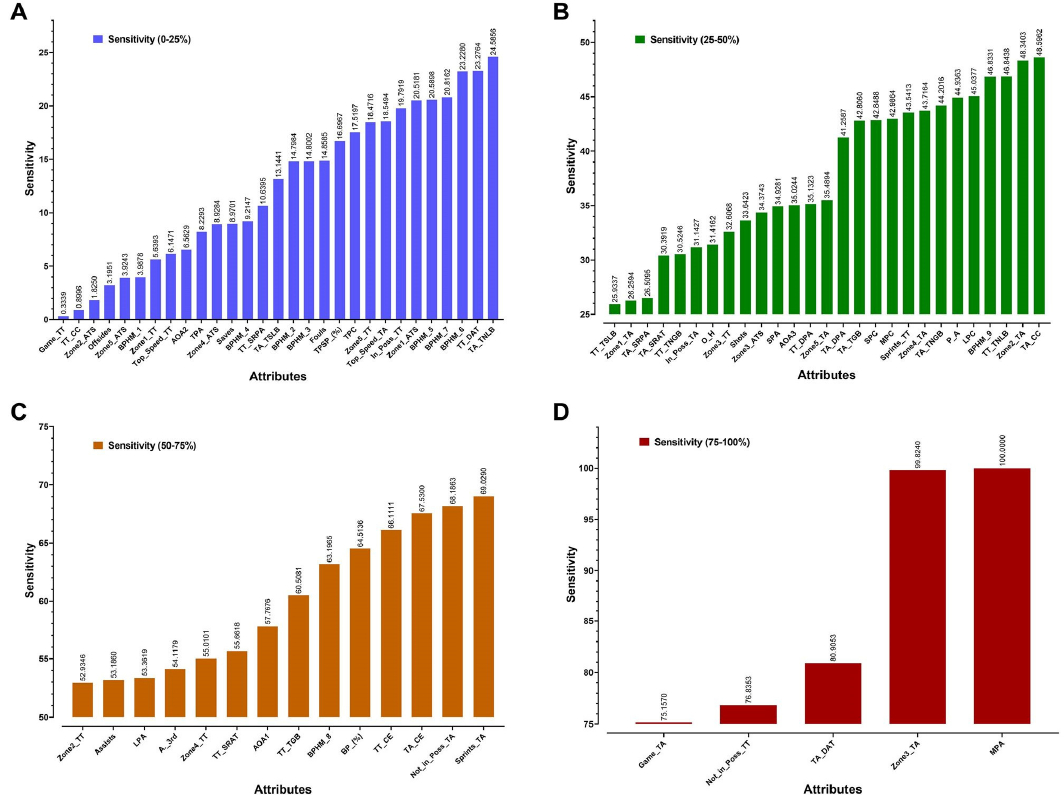
Figure 3. Contribution of match attributes to results (ANN sensitivity analysis); ( A ): sensitivity from 0 to 25%, ( B ): sensitivity from 25 to 50%, ( C ): sensitivity from 50 to 75%, ( D ): sensitivity from 75 to 100%.